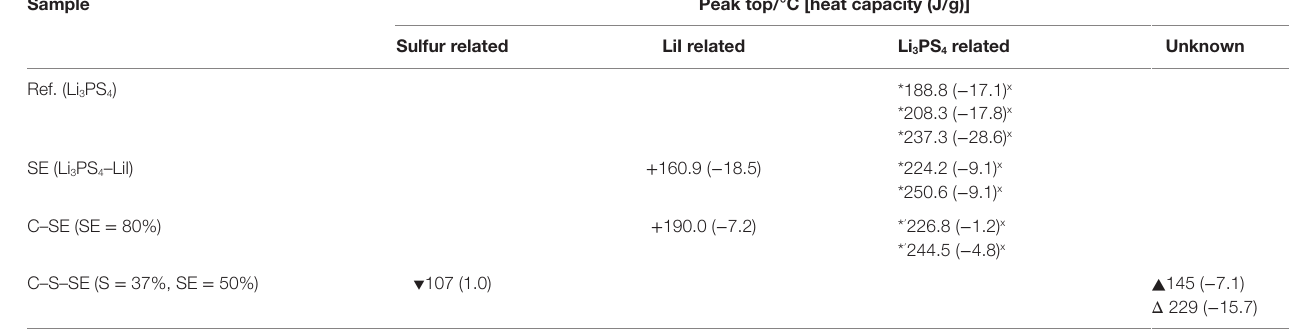
x Vertical partitioning. The symbols before the values correspond to the symbols in Figure 8